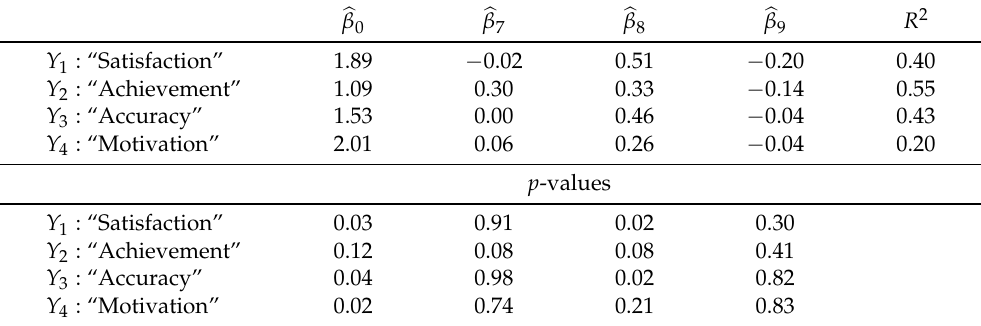
Table 3. Estimated parameters, corresponding p -values, and coefficient of determination R 2 in the regression of performance measures ( Y 1 , . . . , Y 4 ) on selected key training method variables ( X 7 , X 8 , X 9 ) for employees in the banking